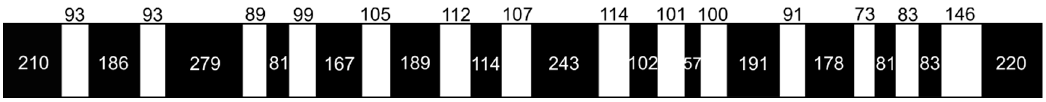
Figure 3. Exon-intron structure of Mi FRS gene. Prediction was obtained from Splign Alignment Tool (https://www.ncbi.nlm.nih.gov/Web/Newsltr/V14N2/splign.html) from NCBI. Exons are represented by black boxes. Numbers represent exon and intron lengths in base pairs.